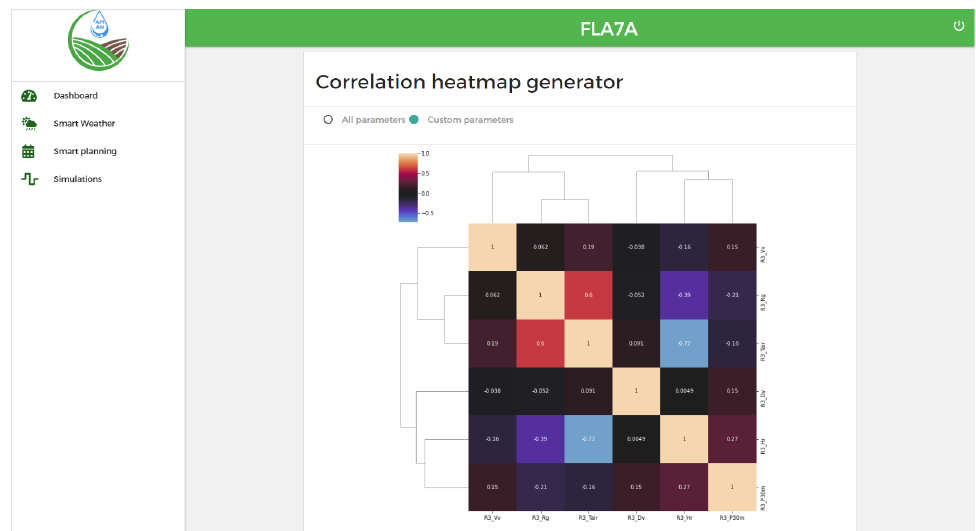
Figure 4. A screenshot of the platform’s data analysis service.